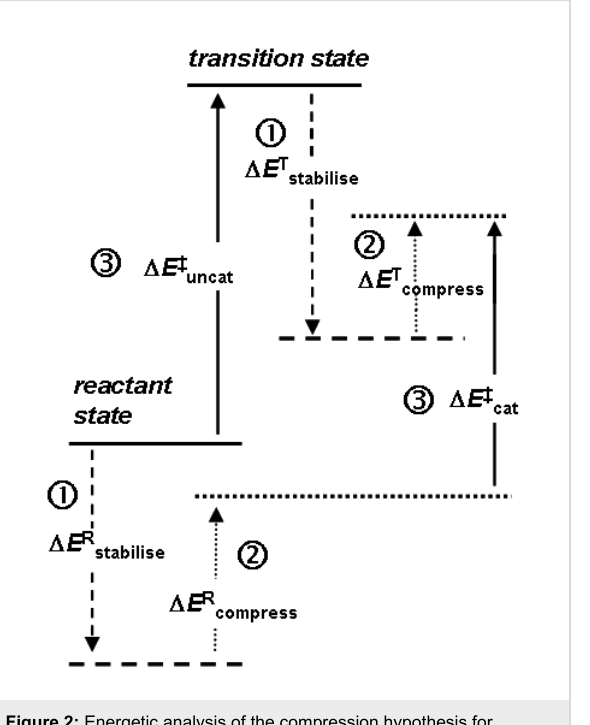
Figure 2: Energetic analysis of the compression hypothesis for enzyme-catalysed methyl transfer.